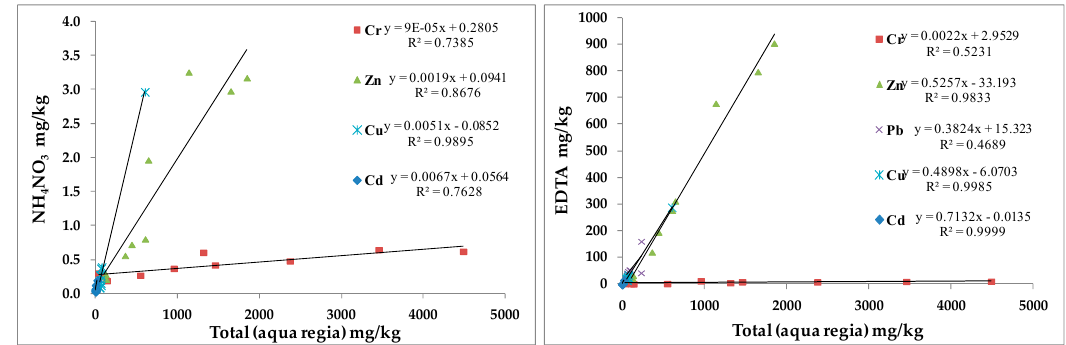
Figure 2. Correlation between the total amount (aqua regia digestion) of Cr, Zn, Pb, Cu, and Cd and the amounts extracted by NH 4 NO 3 and EDTA from the 10 selected soil samples.